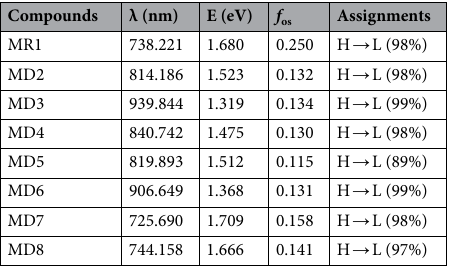
Table 2. Calculated energies, wavelengths (λ max ) and oscillation strengths for MR1 and MD2–MD8 in chloroform.